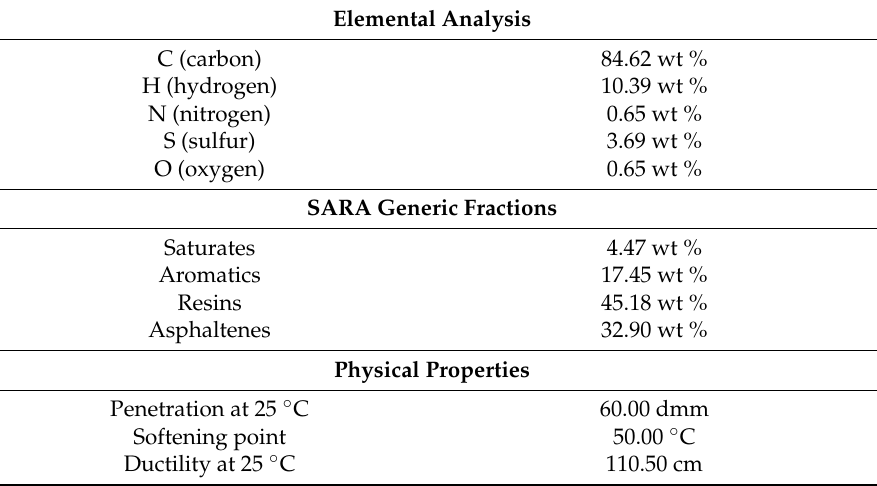
Table 1. Chemical and physical properties of AP-5 asphalt